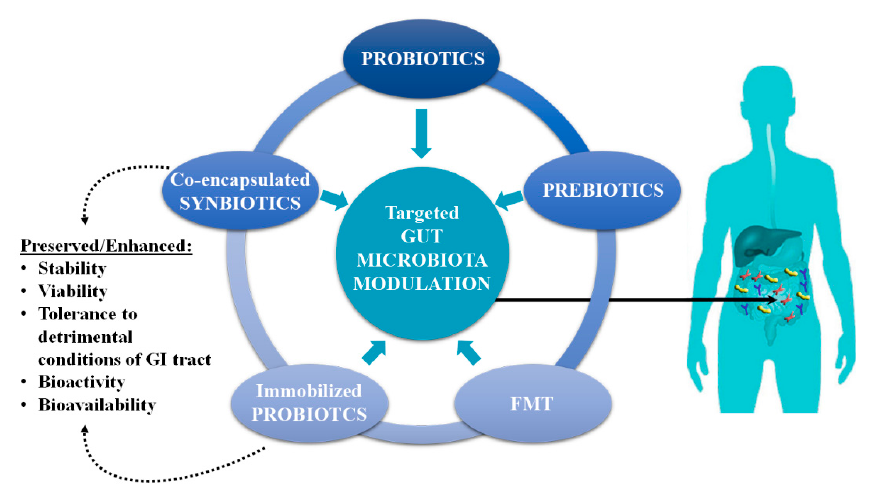
Figure 1. Modern approaches used in the targeted gut microbiota modulation and benefits of co- encapsulated synbiotics and immobilized